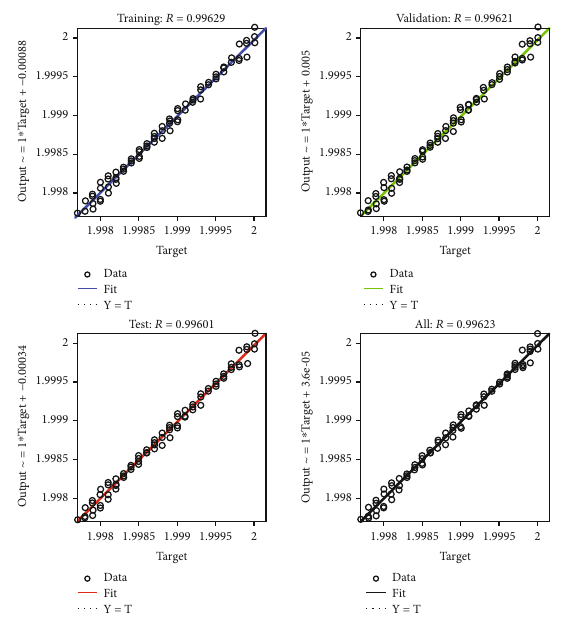
Figure 28: Test, training, and validation of a DNN-current regulator. Table 3: DNN data of the grid system controller. DNN